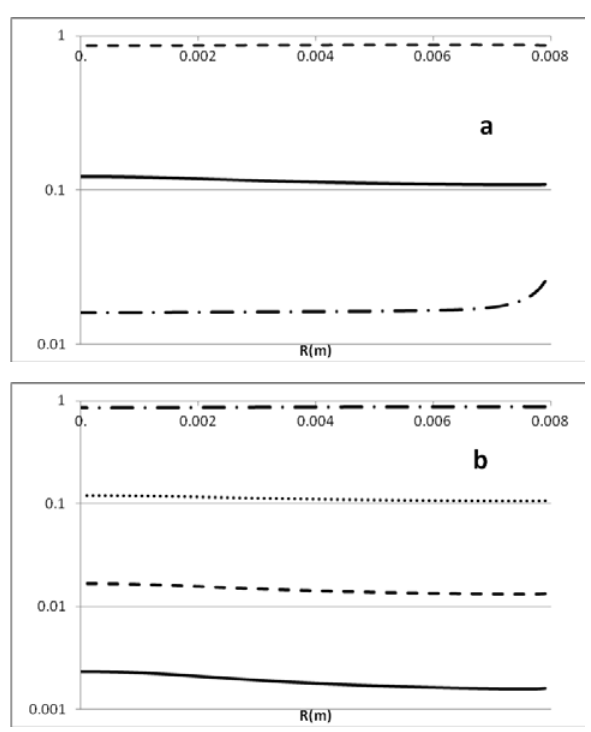
Figure 7 . (a) and (b) — site concentration distributions for models 2 and 3, respectively: C — solid line, CH — dotted line, CH 2 — points line, CH 3 — point-dotted line (logarithmic scale), distance from the substrate center is in m.